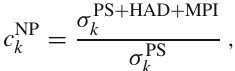
Fig. 4 Overview of the theoretical correction factors. For each of the six analysis bins the NLO QCD (top left), the electroweak (top right), and the NP correction factor (bottom) are shown as a function of p T , avg .